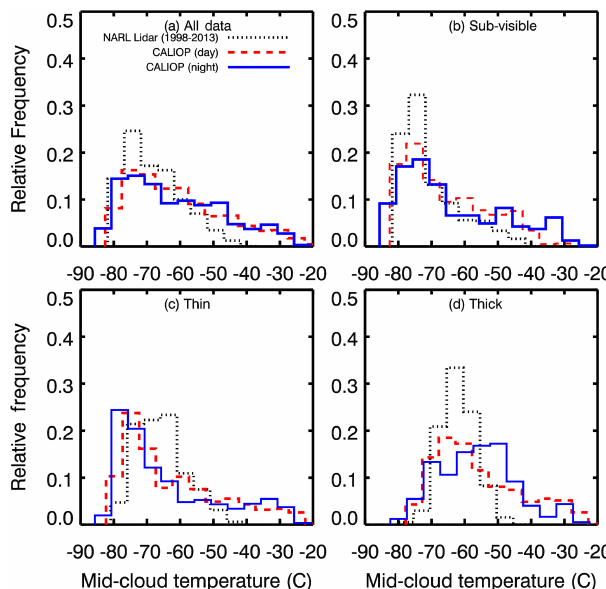
Figure 10. Histograms showing the frequency distribution of mid- cloud temperature in bins of 5 ◦ C for (a) all cirrus cloud layers, (b) sub-visible cirrus ( τ <0.03), (c) thin cirrus (0.03< τ <0.3) and (d) thick cirrus cloud layers ( τ >0.3) obtained from NARL Li- dar (dotted black line), CALIOP daytime (dashed red line) and CALIOP night-time (solid blue line) data